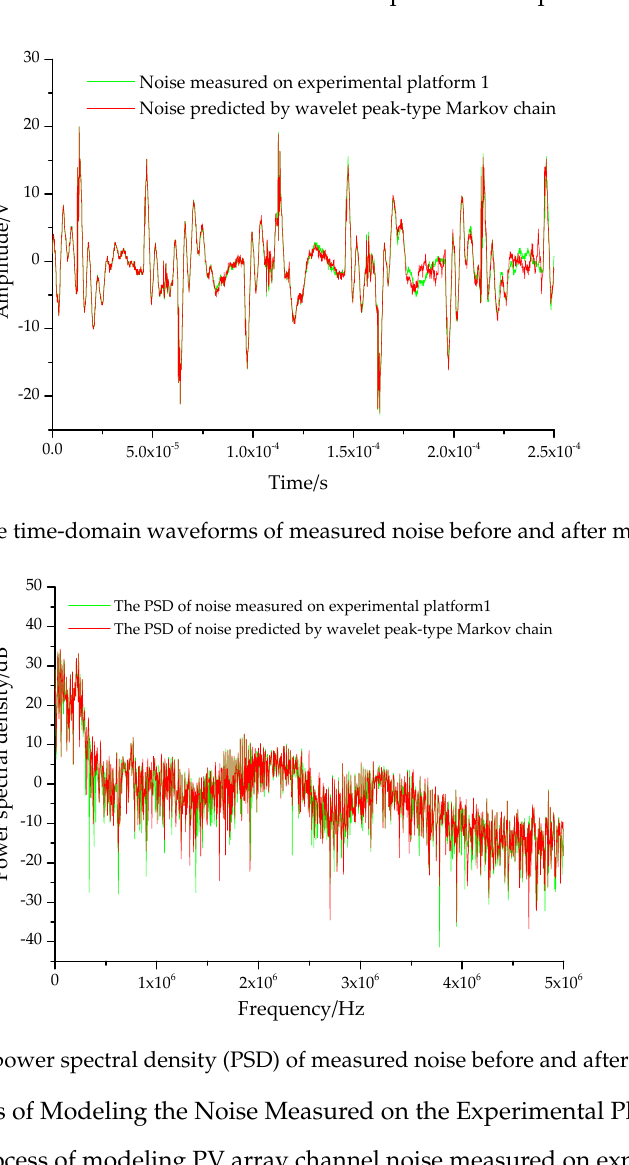
14 of 19 Figure 11 . Cont. ( b ) Figure 11. The part wavelet packet coefficient group before and after predicted. ( a ) Original part wavelet packet coefficient group; ( b ) Part wavelet packet coefficient group of peak-type Markov chain prediction.